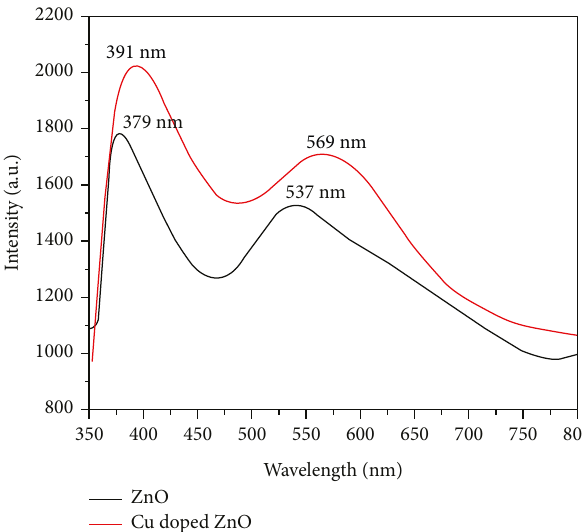
Figure 5: PL spectra of pure and Cu-doped ZnO NPs.